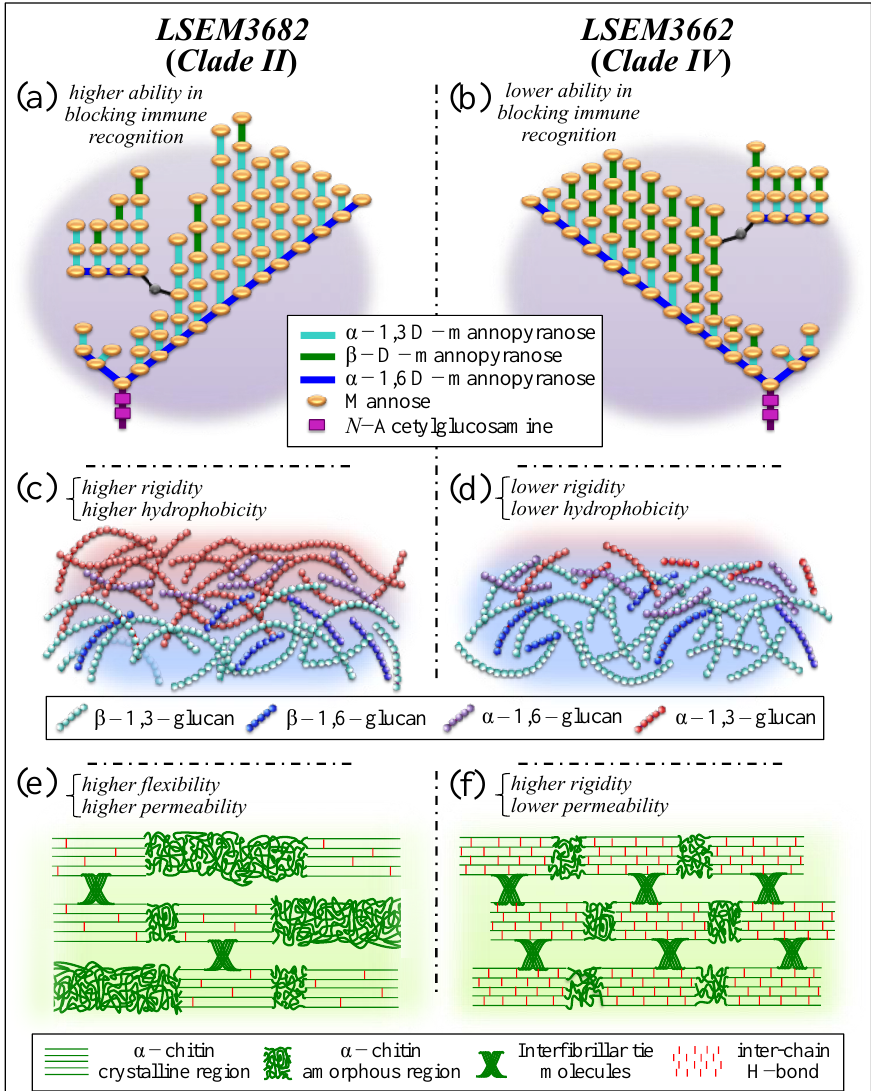
Figure 13. Summary, in three separate sections, of the structural differences in cell walls between LSEM3682 (Clade II) and LSEM3662 (Clade IV); ( a ) and ( b ): mannopyranose structure, ( c ) and ( d ): glucan structure, and ( e ) and ( f ): chitin structure.